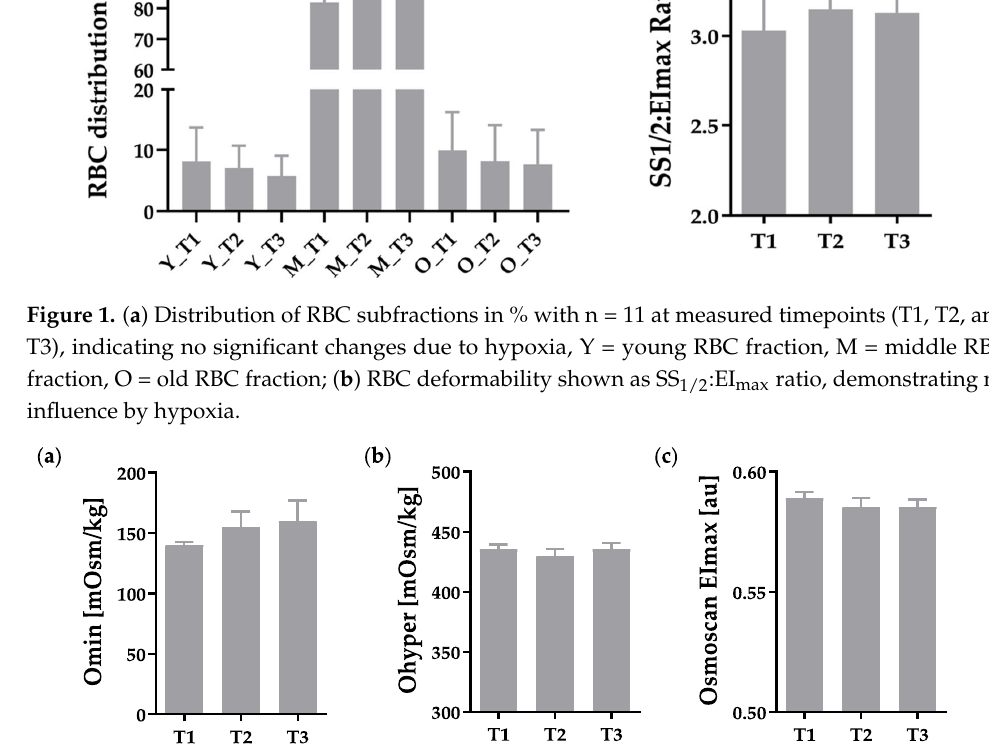
trite/RSNO/Fe ‐ NO concentration (Figure 3b) remained unaffected by hypoxia exposure.